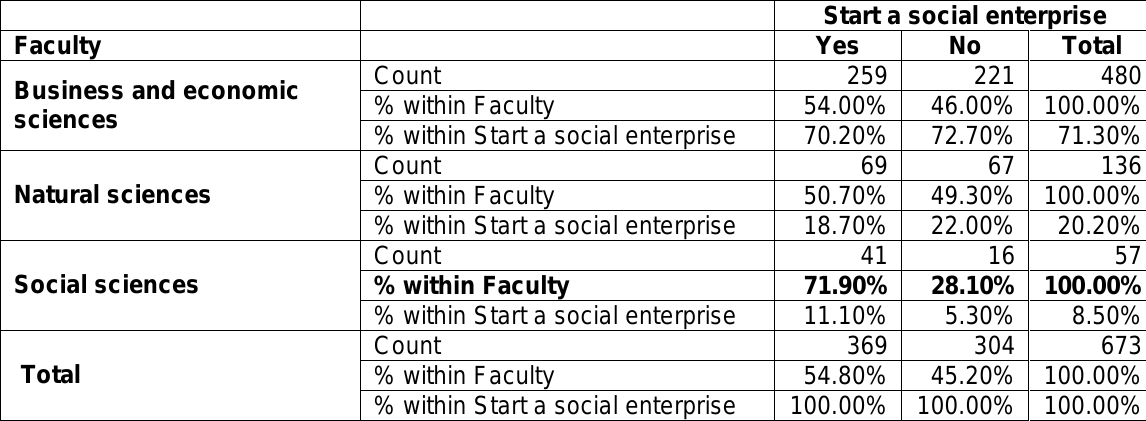
Table 7: The impact of faculty on the intention to establish a social enterprise Start a social enterprise Faculty Yes No Total Count 259 221 480 Business and economic % within Faculty 54.00% 46.00% 100.00% sciences % within Start a social enterprise 70.20% 72.70% Count 69 % within Faculty 50.70% % within Start a social enterprise % within Faculty % within Start a social enterprise 11.10% Count % within Faculty % within Start a social enterprise 100.00%